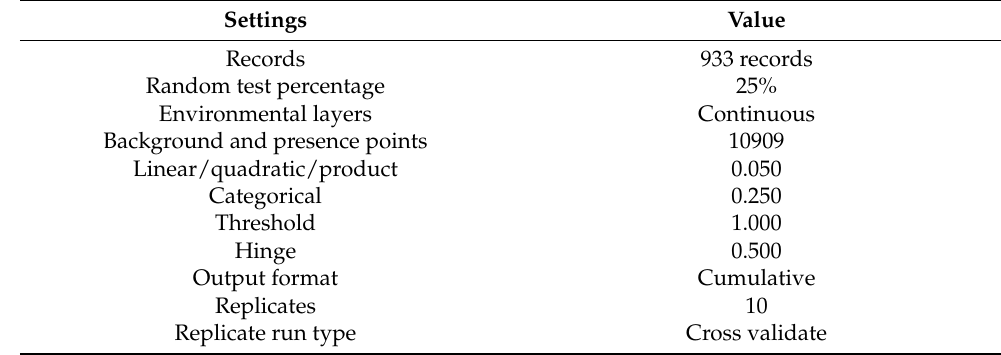
Table 3. The selected parameters used to run the maximum entropy modeling in